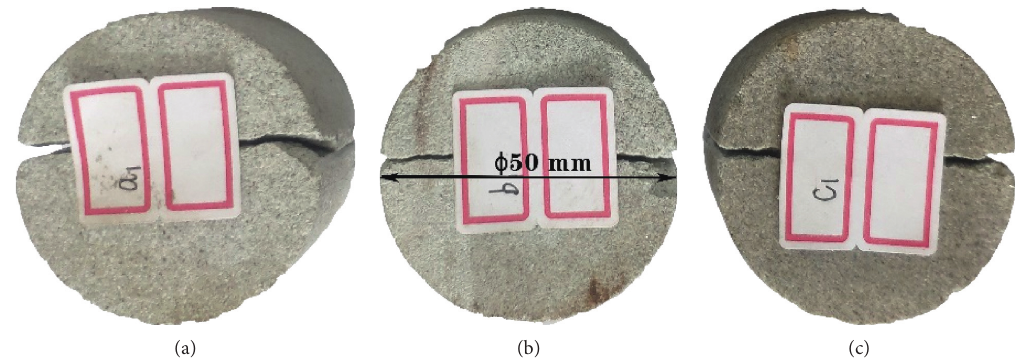
Figure 7: Macroscopic failure modes of rock samples on different moisture conditions during the Brazilian splitting test.